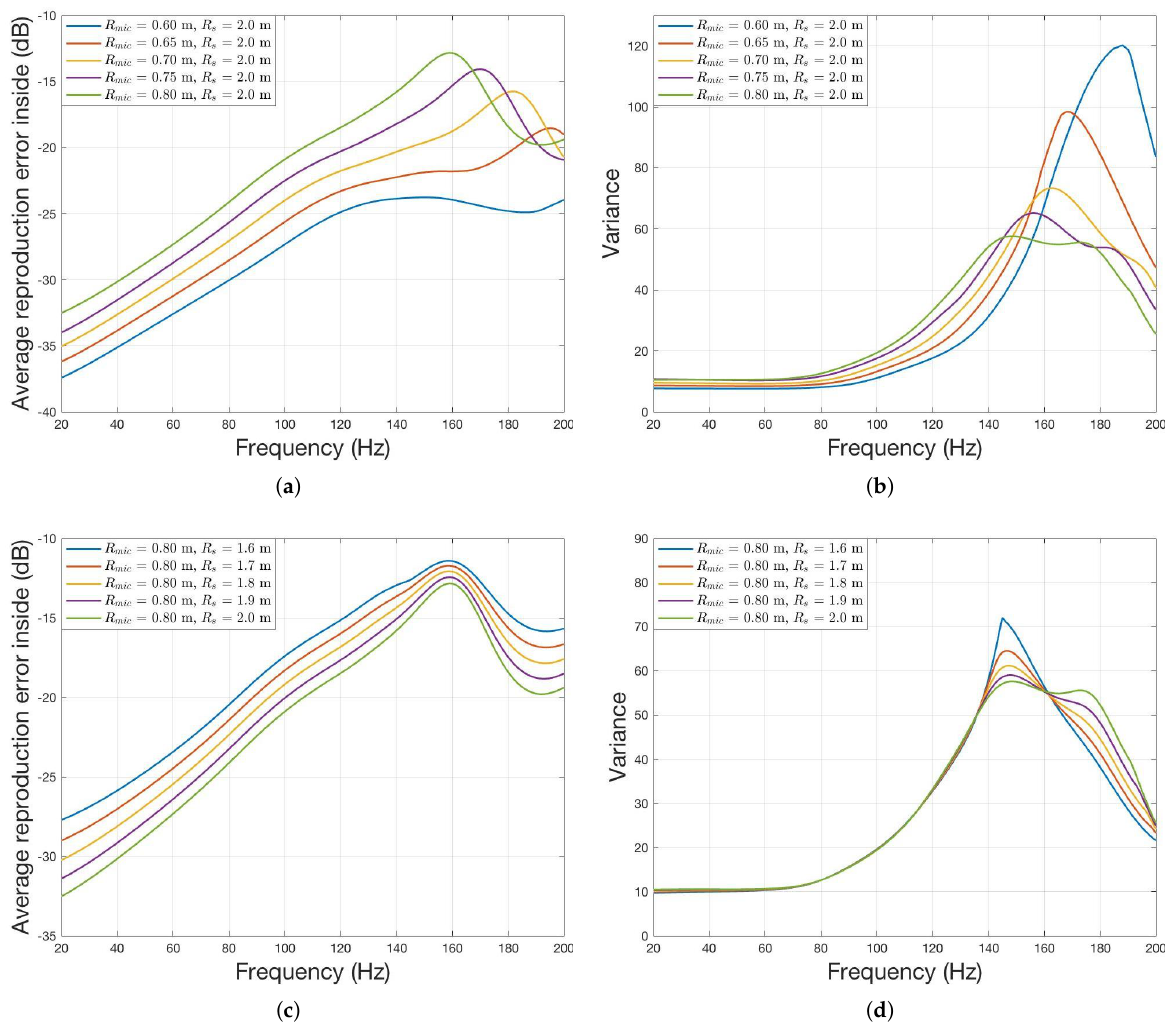
Figure 5. Wave field reproduction error and variance with respect to the radii of the microphone and loudspeaker array. ( a , c ) Average wave field reproduction error. ( b , d )